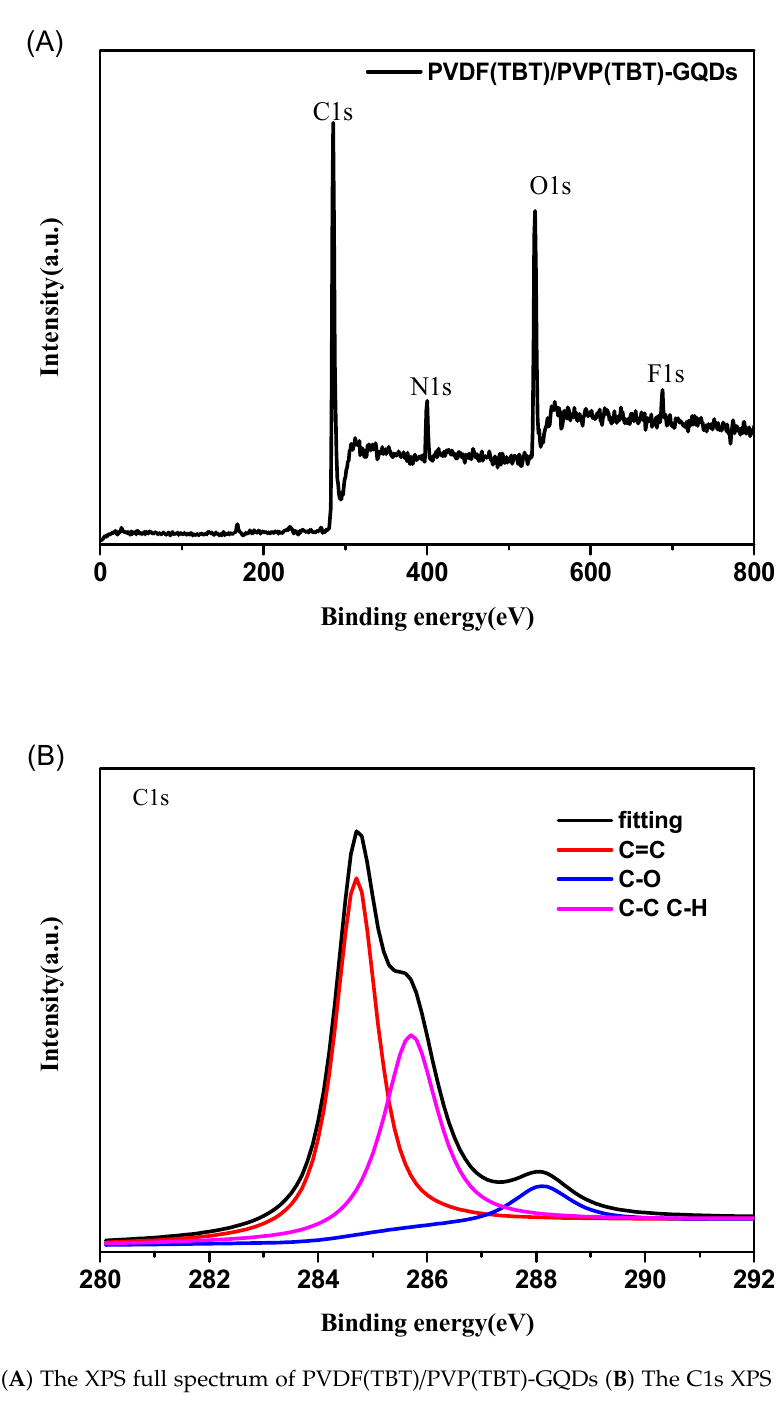
Figure 5. ( A ) The XPS full spectrum of PVDF(TBT) / PVP(TBT)-GQDs ( B ) The C1s XPS spectrum of PVDF(TBT) / PVP(TBT)-GQDs.